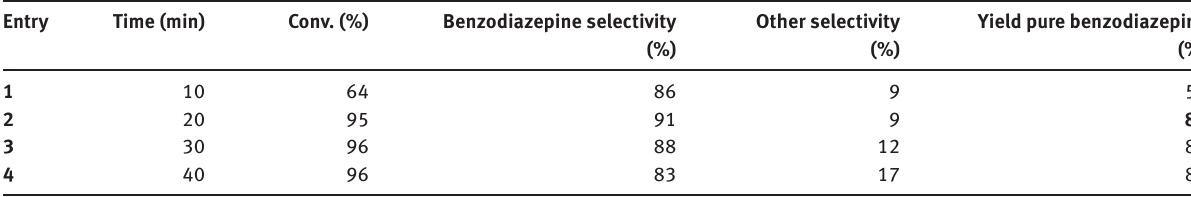
Table 4: Time effect for PVA 60-100.